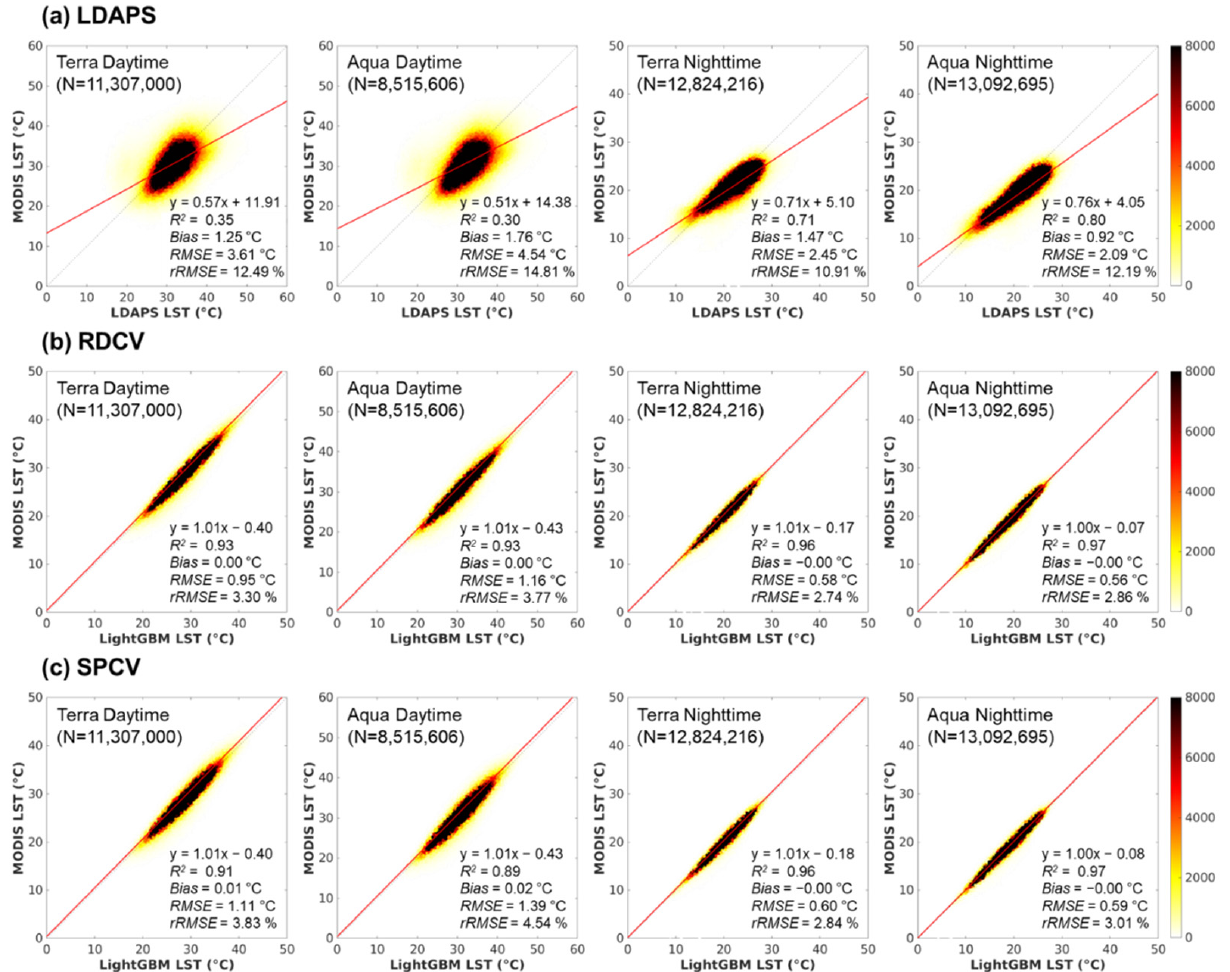
Figure 3. Performances of ( a ) LDAPS and the proposed LightGBM model’s ( b ) RDCV and ( c ) SPCV for four clear-sky MODIS LSTs (i.e., Terra and Aqua for daytime and